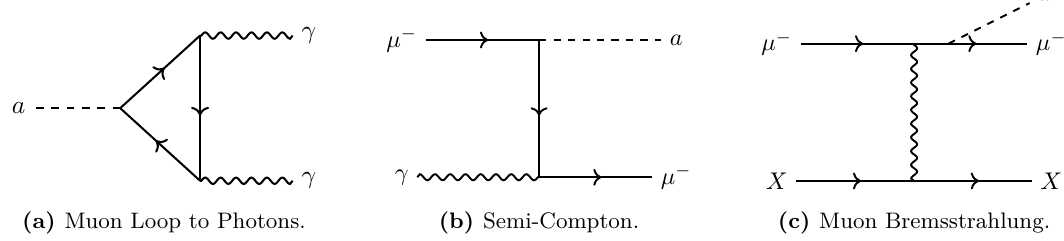
Figure 6. Dominant supernova processes which lead to anomalous energy loss for an axion a coupled to muons. Crossed versions of these diagrams also contribute to the cross